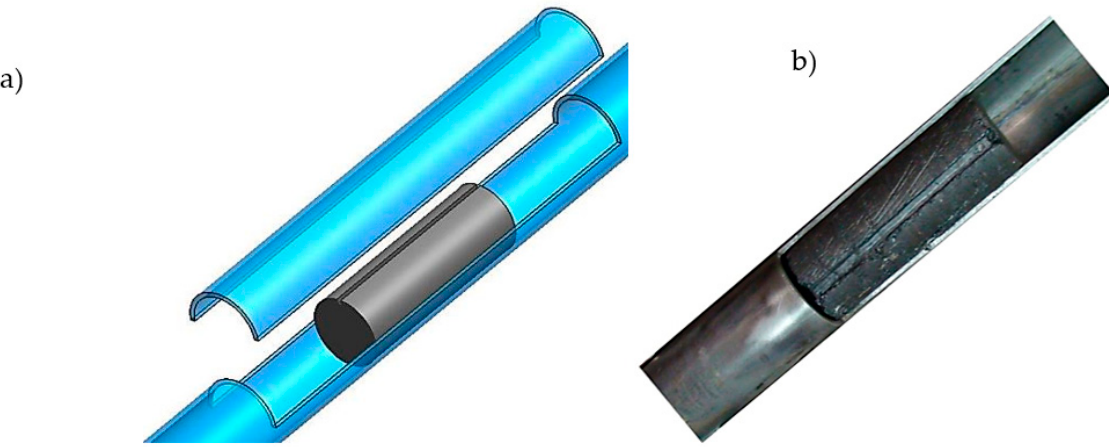
Figure 4. View of the coal sample: ( a ) model view, ( b ) real coal sample in the reactor.